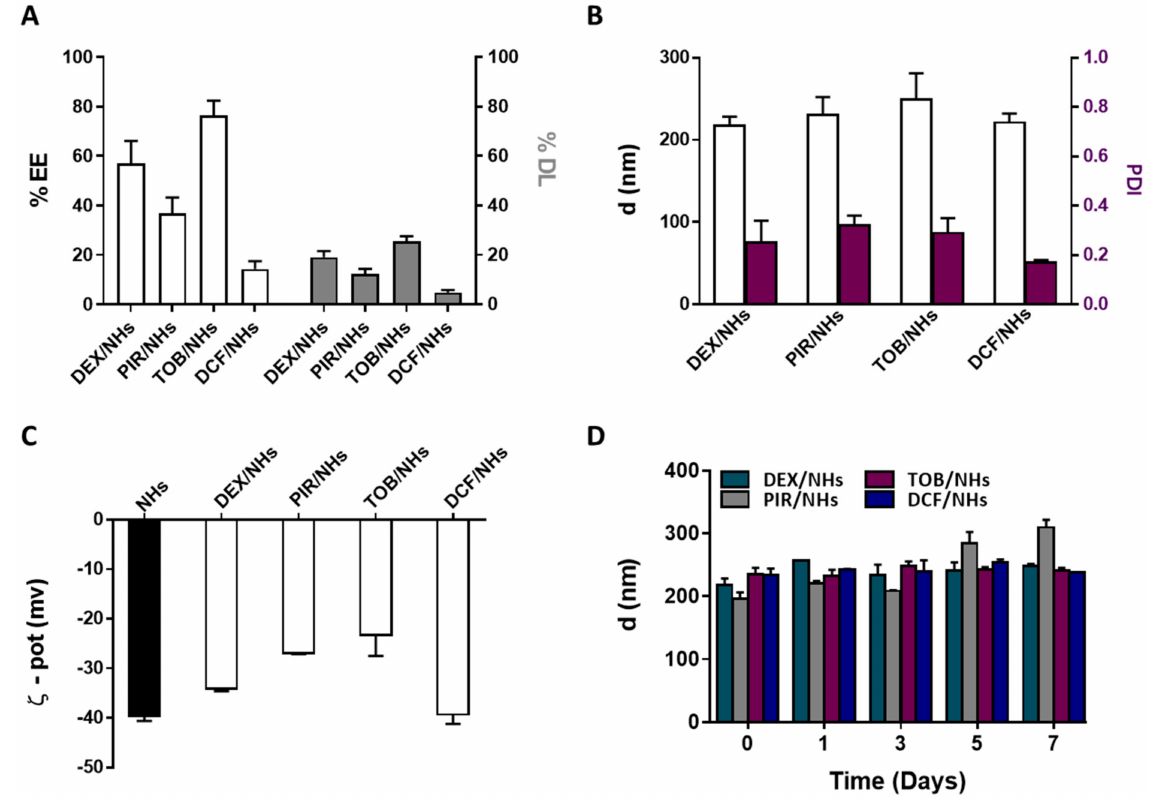
Figure 4. %EE and %DL of DEX/NHs, PIR/NHs, TOB/NHs and DCF/NHs ( A ). Mean diameter and PDI ( B ) and ζ -pot ( C ) of empty and drug-loaded NHs. Mean diameter of DEX/NHs, PIR/NHs, TOB/NHs and DCF/NHs in PBS (0.01 M, pH = 7.4) as a function of the time, at 4 ◦ C ( D ). All data are expressed as the mean value ± standard deviation. Results were obtained in triplicate ( n =